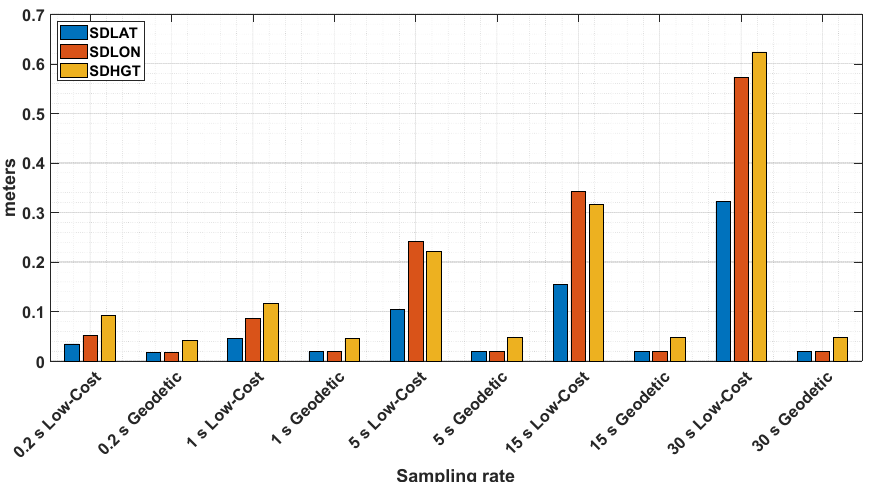
Figure 10. Standard deviation (95%) of estimated positions of low-cost and geodetic receivers by processing with PPP-kinematic mode.